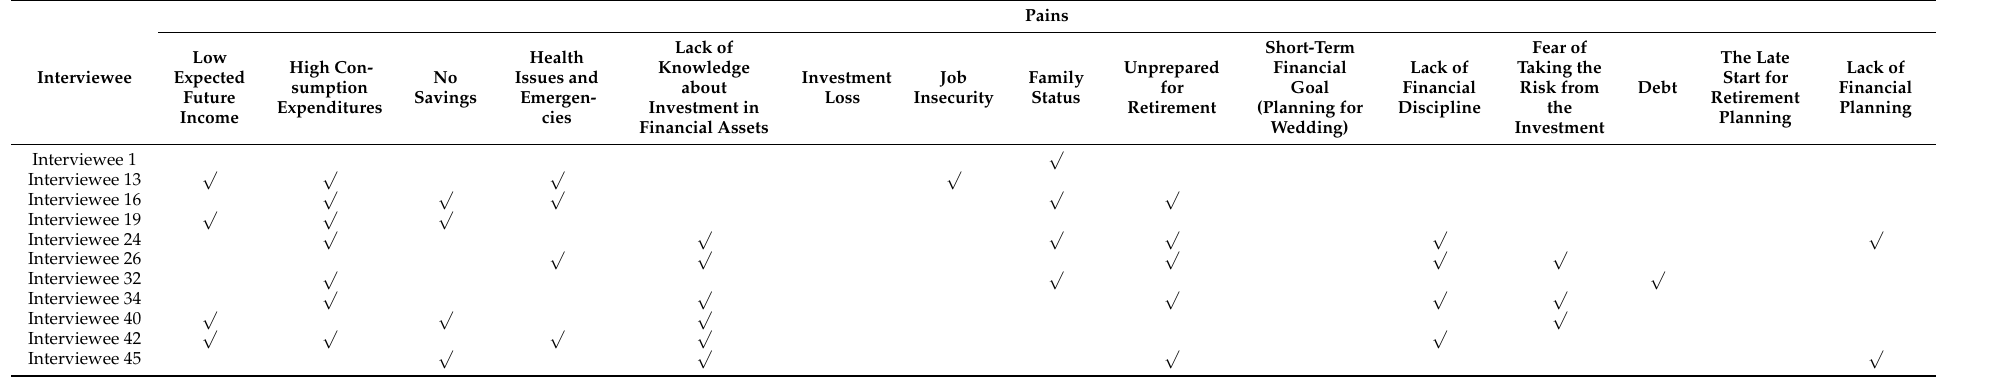
Table 7. Most common pains from interviewees of segment